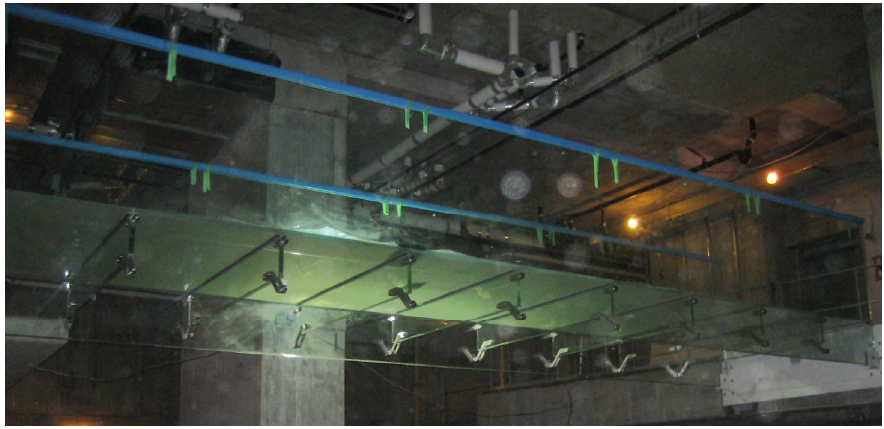
Figure 11: Completed glass